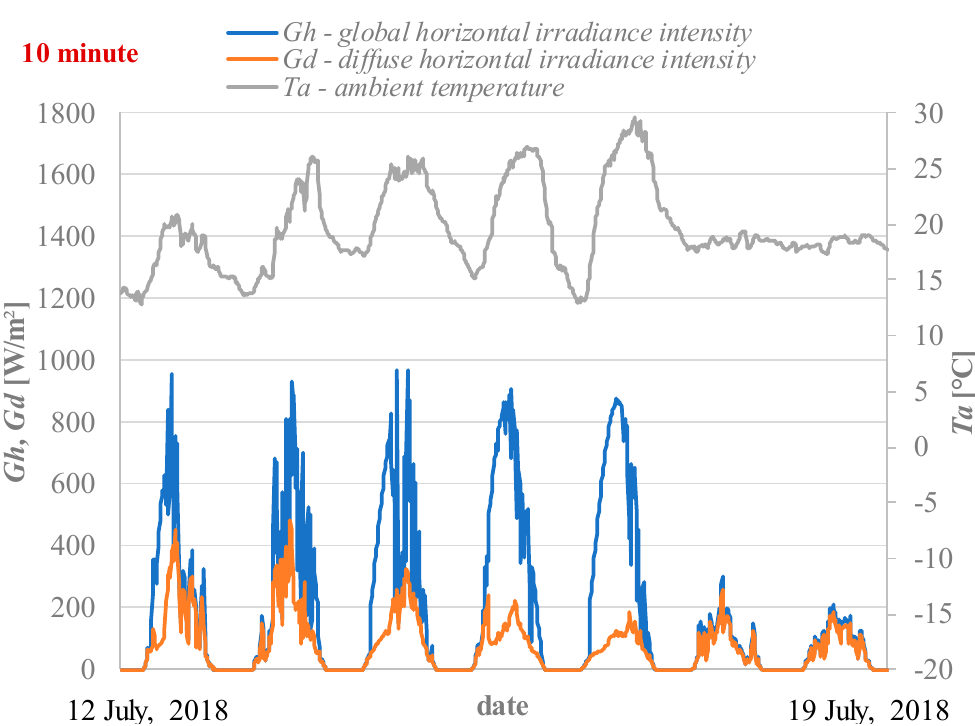
Figure 3. Weather conditions during the selected week of observation using a 10 min aggregation interval.